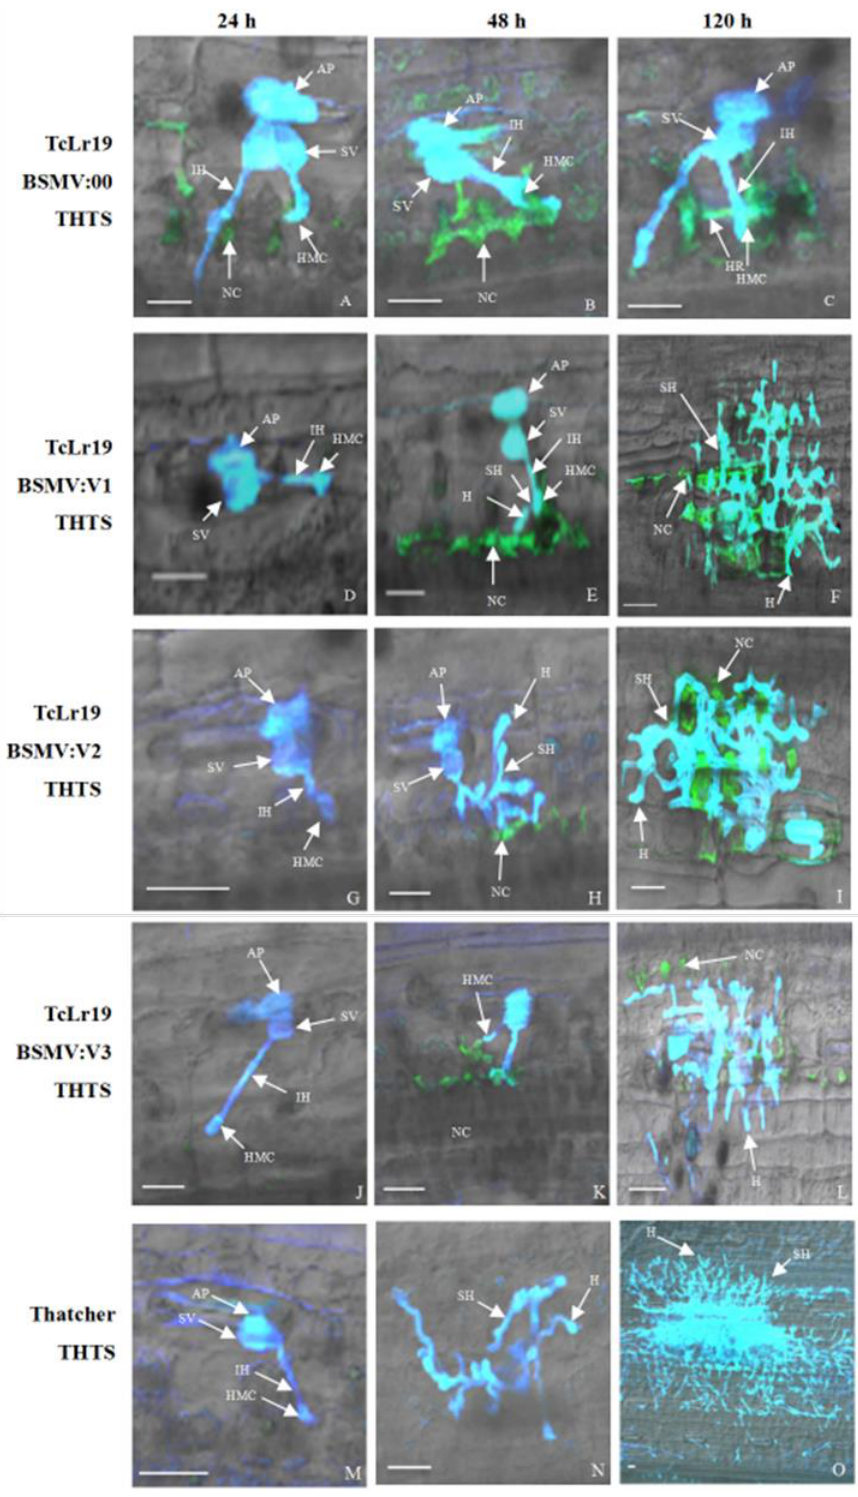
Figure 5. Histopathological observation of BSMV-infiltrated TcLr19 wheat leaves at 24 h, 48 h, and 120 h after inoculation with THTS. ( A – C ): TcLr19 infiltrated by BSMV:00 inoculation with THTS; ( D – L ): TcLr19 infiltrated by BSMV:V1-3 and inoculation with THTS; ( M – O ): Thatcher after inoculation with THTS; AP: appresorium; IH: infection hypha; SV: substomatal vesicle; HMC: haustorial mother cell; SH: second hypha; H: haustorium; NC: necrotic cell. Scale bars are 30 µ